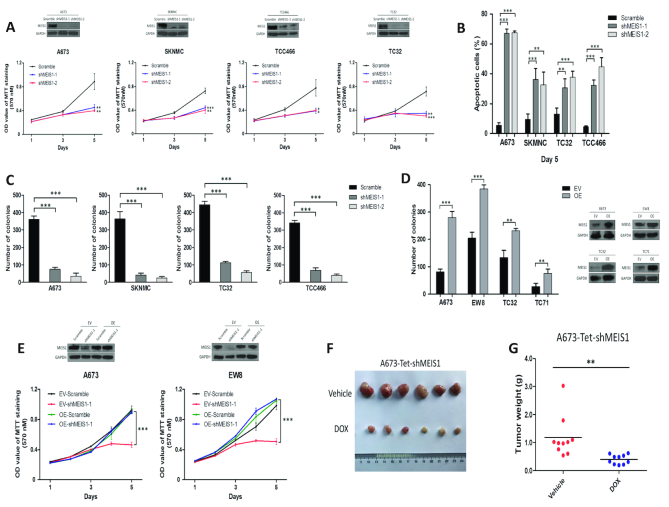
Oncogenic function of MEIS1 in Ewing sarcoma, (A) MTT assay, (B) apoptosis assay and (C) soft-agar assay evaluating the knockdown effects of MEIS1 on Ewing sarcoma cells. Error bars represent mean ± SD of three replicates (*P < 0.05, **P < 0.01, ***P < 0.001). Efficiency of MEIS1 knockdown in Ewing sarcoma cells was shown by immunoblotting assays. (D) Ewing sarcoma cells were stably transfected with either empty vector (EV) or plasmid encoding MEIS1 (OE). Immunoblotting was performed to determine MEIS1 expression, and cell anchorage-independent growth was measured by soft agar assay. Error bars represent mean ± SD of three replicates (**P < 0.01, *** P < 0.001). (E) A673 and EW8 cells stably expressing indicated plasmids were infected again with either shMEIS1 or shRNA control (Scramble), and subjected to immunoblotting and MTT assays. Bars represent mean ± SD of three replicates (***P < 0.001). (F–G) Nude mice were inoculated subcutaneously with A673 cells stably expressing inducible MEIS1 shRNA (A673-Tet-shMEIS1). Mice were randomly allocated to either doxycycline (DOX)-treated or vehicle-treated groups (n = 5 per group). (F) Representative images and (G) weights of resected tumors at the end point (**P < 0.01).